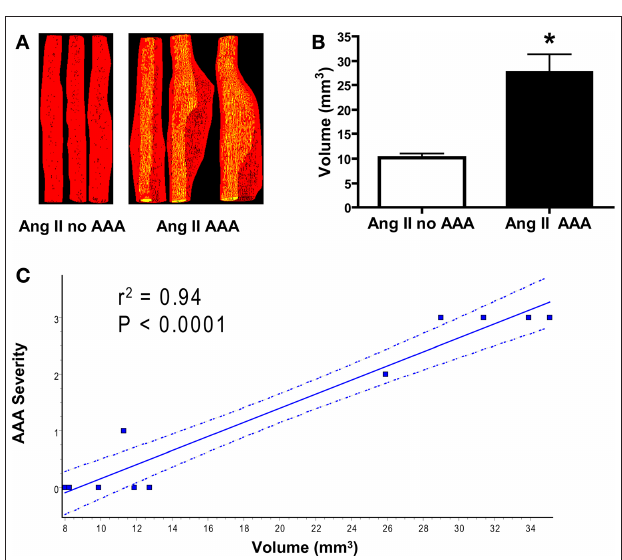
FIguRE 4 | Ang II-induced AAA detected by ultrasound imaging and further verified by dissection and histology. A representative abdominal aorta without AAA formation (upper panels; n = 24) and with AAA (lower panels; n = 25) after 4-week Ang II infusion: (A,D) Ultrasound images; (B,E) gross morphological view; (C,F) Movat’s pentachrome histological staining.